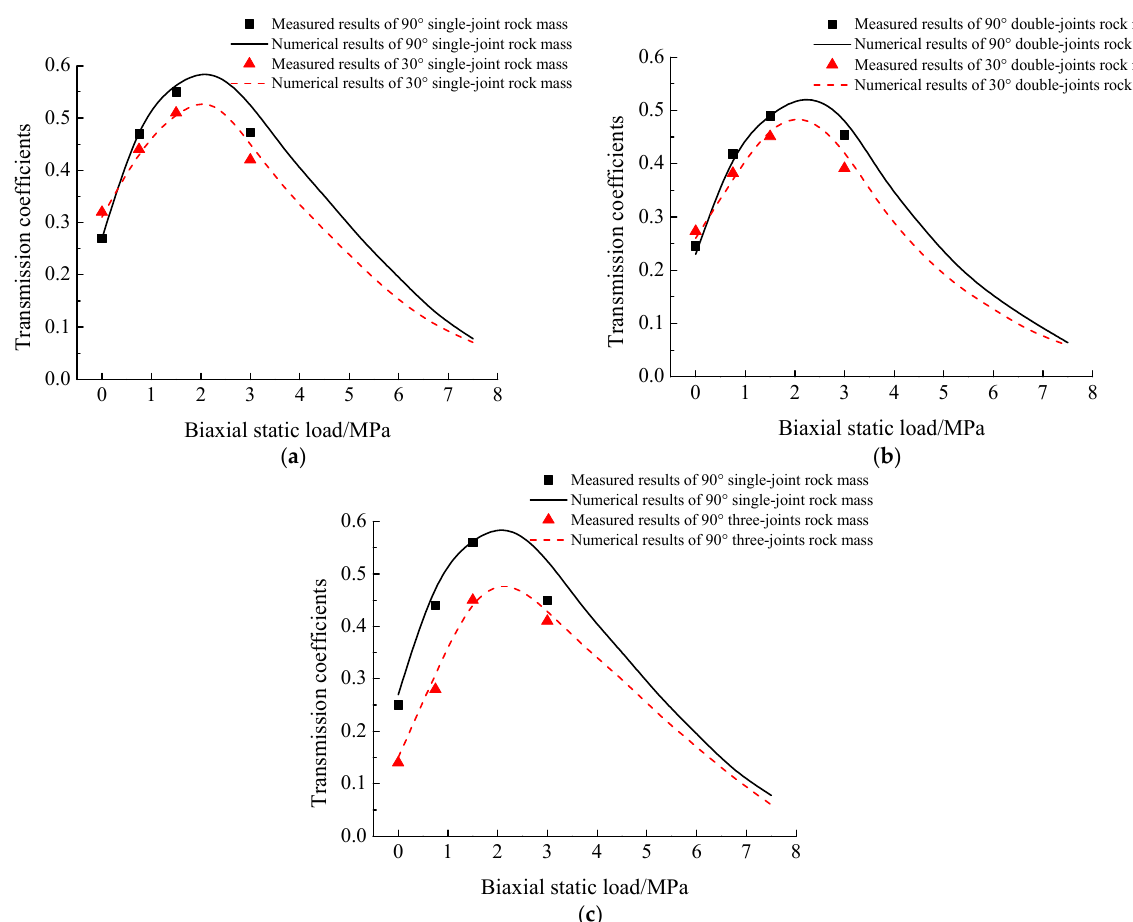
Figure 10. Measured and numerical transmission coefficients of jointed rock masses under different static loads: ( a ) T1 sample; ( b ) T2 sample; ( c ) T3 sample.